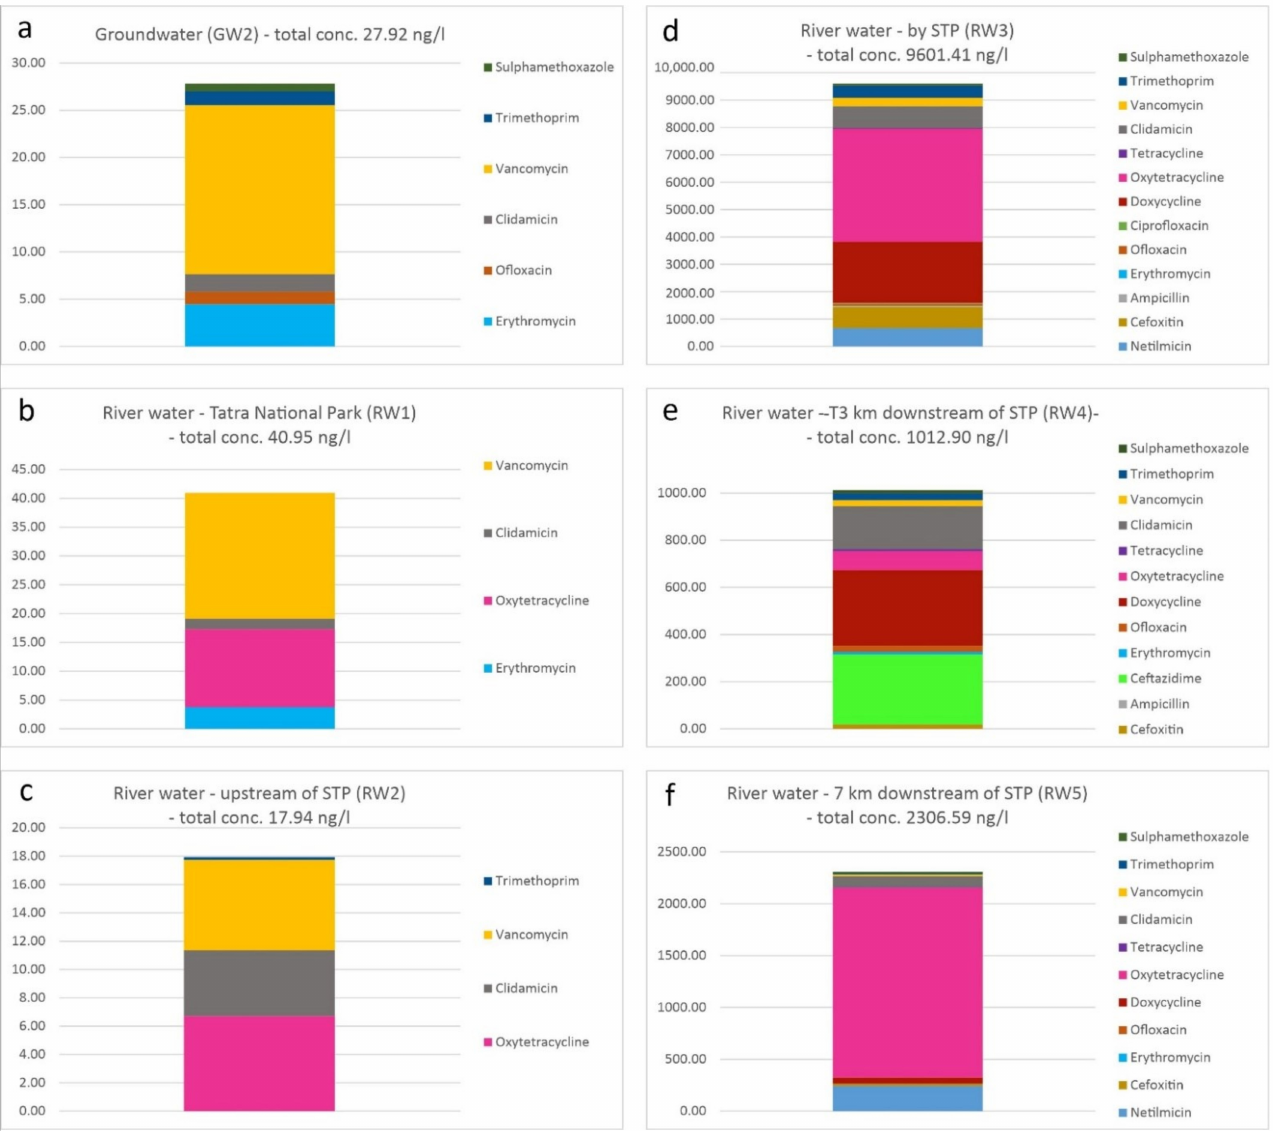
Figure 3. ( a – f ) Concentrations (ng/L) and share of antimicrobial agents in the total concentration of antimicrobial agents detected in each